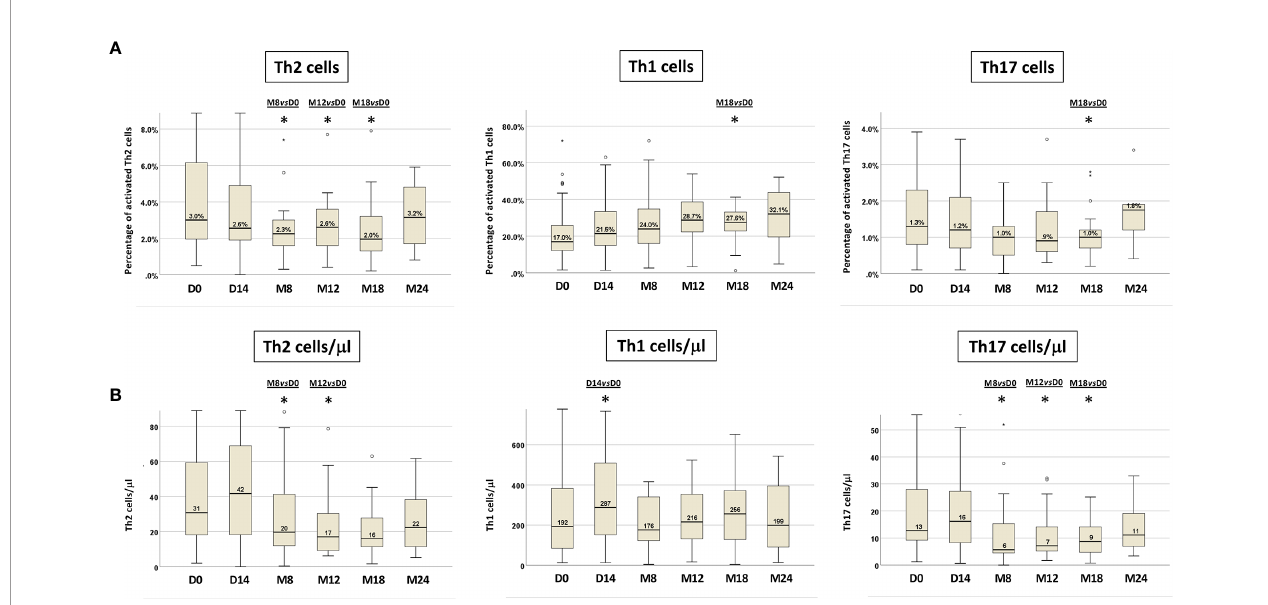
FIGURE 3 | T-cell cytokine production in paired PB samples before and during ibrutinib treatment. The intra-individual variations of Th2, Th1 and Th17 activated cells are expressed as: (A) percentages of Th2, Th1 and Th17 cells; (B) absolute numbers of Th2, Th1 and Th17 cells. Samples at D0, n=71; at D14, n=50; at M8, n=30; at M12, n=25; at M18, n=22; at M24, n=10 (Wilcoxon paired test D14 vs D0, M8 vs D0, M12 vs D0, M18 vs D0, M24 vs D0; *p<0.05).